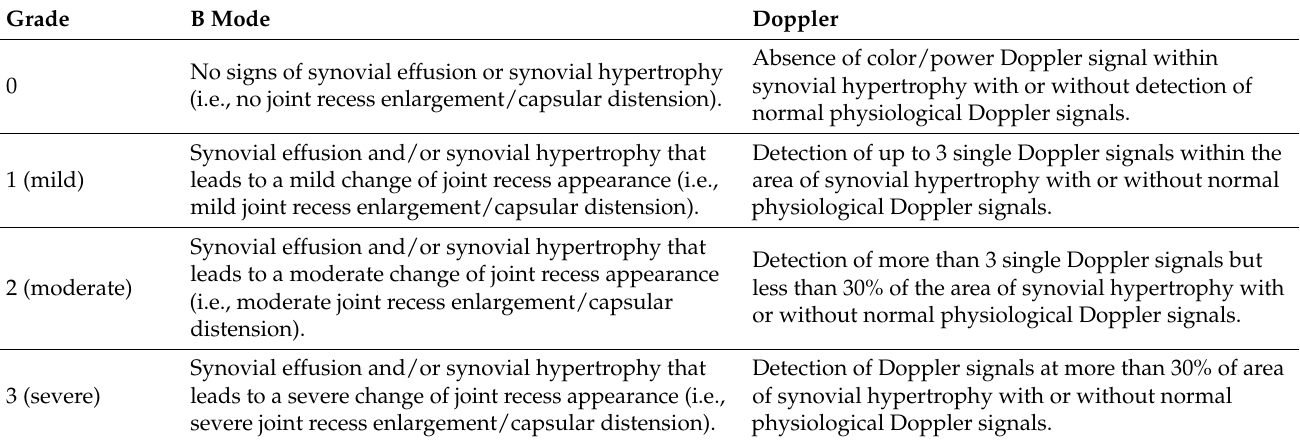
Table 1. OMERACT combined scoring system for synovitis in